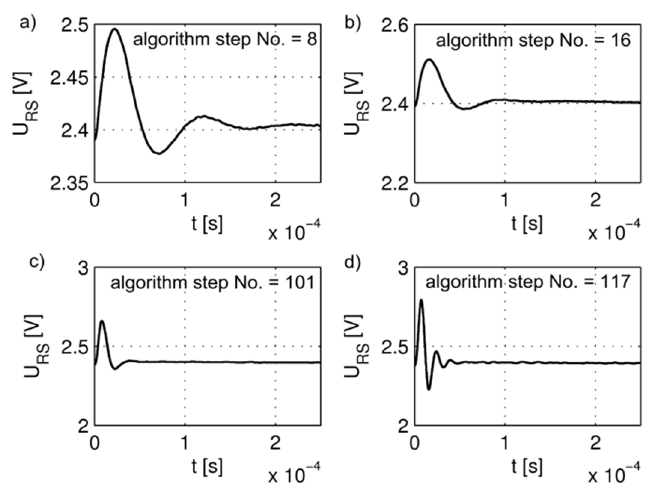
Figure 9. The dynamic response of the hot-wire anemometer in individual stages of the process of automatic adjustment: ( a ) first adjustment stage; ( b ) second adjustment stage; ( c ) third adjustment stage; ( d ) fourth adjustment stage.